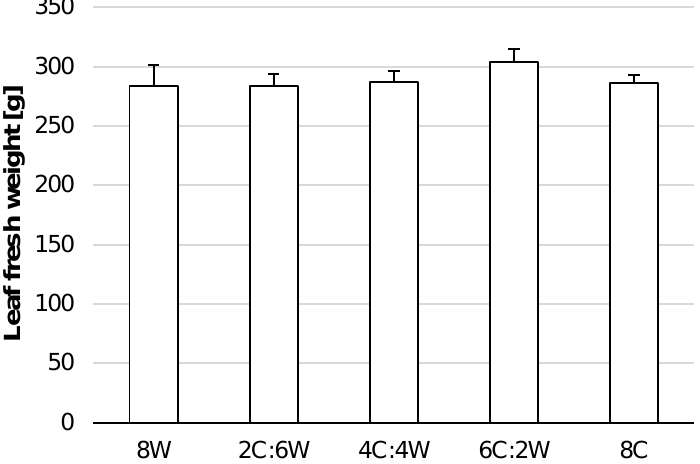
Figure 8. Leaf relative chlorophyll content [SPAD], 8 and 35 DAT. Vertical bars denote standard errors of means. Different letters denote significant differences among treatments according to the Student’s t -test at p ≤ 0.05.